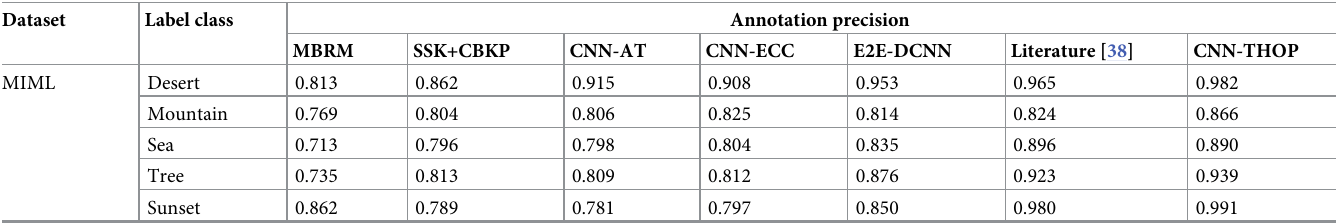
Table 4. Comparison of annotation precision for each class in different datasets using different algorithms.